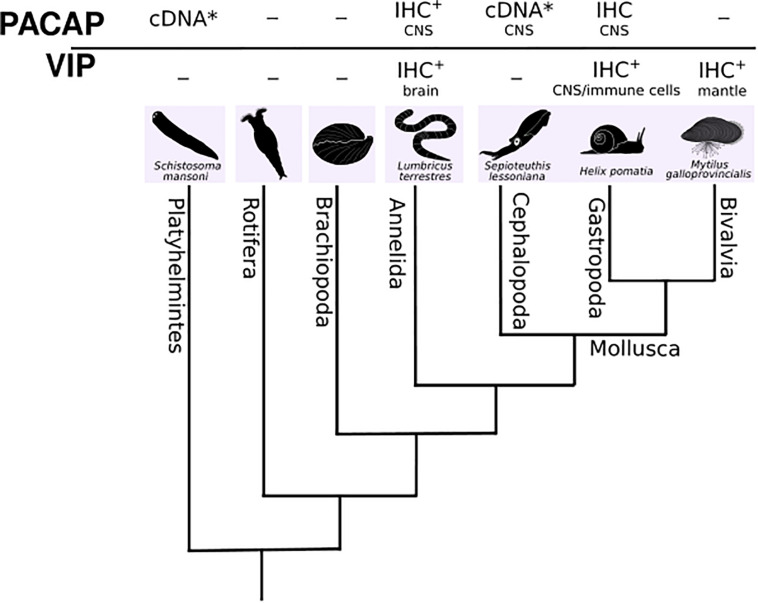
A dendrogram representing the phylogenetic relationships of the main Lophotrochozoan phyla. Available molecular and expression data (IHC) for putative PACAP or VIP is presented (Reglödi et al., 2000; Somogyvári-Vigh et al., 2000; Hernádi et al., 2008; Boros et al., 2010; Pirger et al., 2010a). The tissues where putative PACAP or VIP were found are also indicated. - no data available; * partial cDNA; + heterologous antibody.